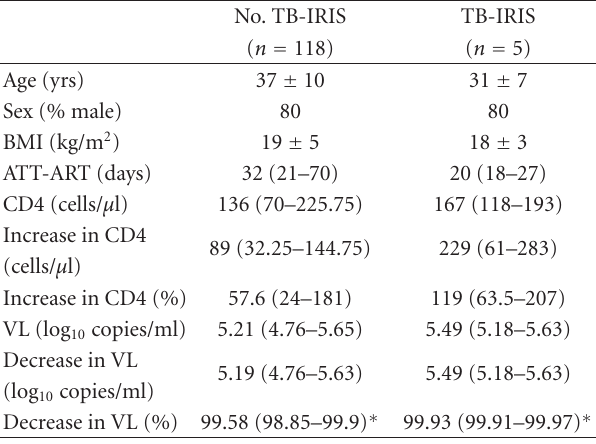
Table 5: Comparison characteristics between patients with and without TB-IRIS in 123 patients with HIV-TB.